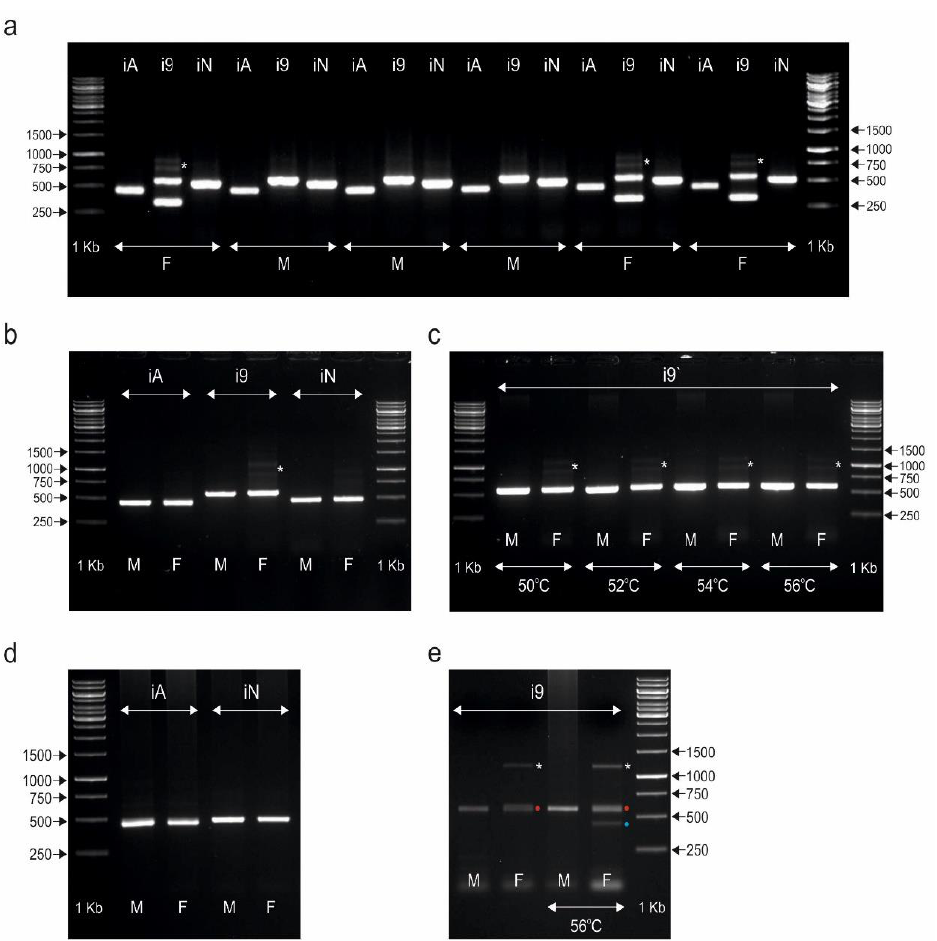
Figure 2. PCR products obtained for male (M) and female (F) individuals of Eudromia elegans ( a ), Crypturellus tataupa ( b , c ), and Tinamus solitarius ( d , e ) species using CHD1iA (iA), CHD1i9 (i9), and NIPBLi16 (iN) markers. The amplicons were resolved in 1% agarose gel. Arrows and numbers correspond to the location and size (in bp) of the DNA molecular marker (1 kb) run on the same gel. In the case of the CHD1i9 marker, annealing temperatures other than 51 °C are marked appropriately if they were used. Asterisks, red and blue dots indicate additional bands detected only in females.